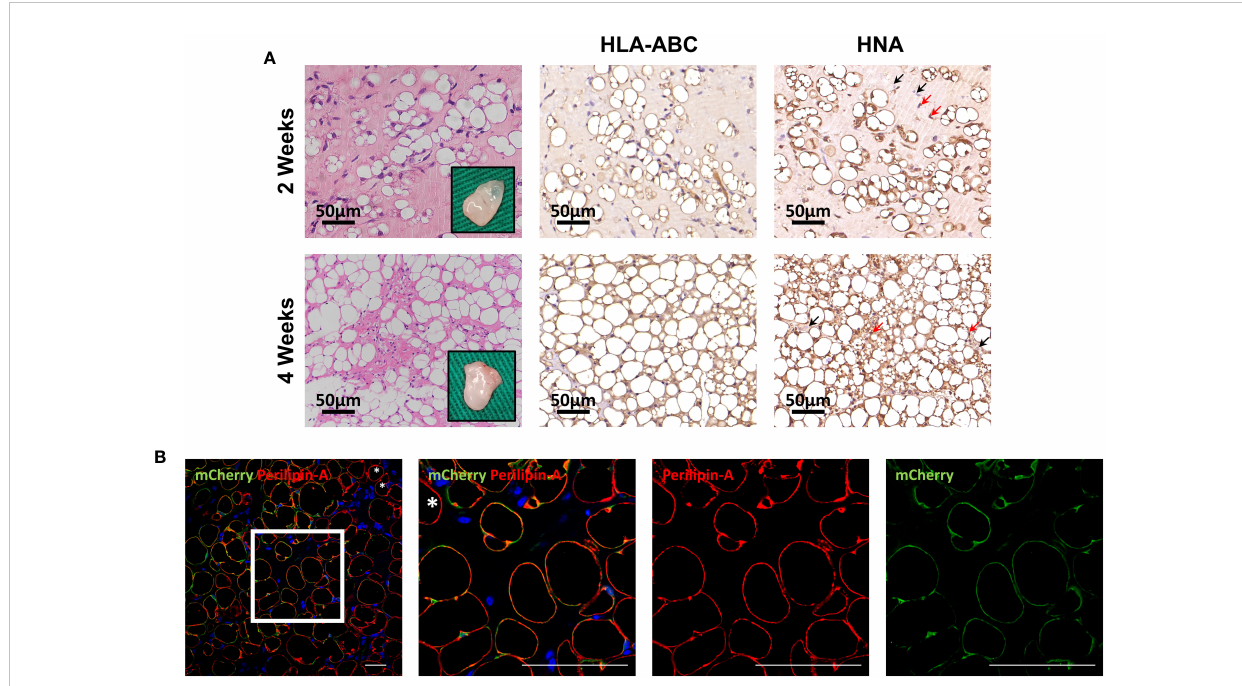
FIGURE 4 HemMCs form adipocytes in vivo . HemMCs or mCherry-labeled HemMCs were mixed with Matrigel and injected into nude mice. (A) HemMC/ Matrigel implants were harvested at 2 and 4 weeks and then subjected to H&E staining or IHC staining of HLA-ABC and HNA. Scale bars=50 m m. (B) mCherry-labeled HemMC/Matrigel implants were harvested at 4 weeks and then subjected to immuno fl uorescence staining for mCherry (green) and perilipin-A (red). Short scale bars=50 m m; long scale bars=100 m m. Red arrows indicate representative HNA-positive nuclei. Black arrows indicate representative HNA-negative nuclei; * indicates representative mCherry-negative adipocytes. HemMCs, infantile hemangioma mural cells; H&E, hematoxylin and eosin; IHC, immunohistochemistry; HLA-ABC, human leukocyte antigen-ABC. HNA, human nuclei